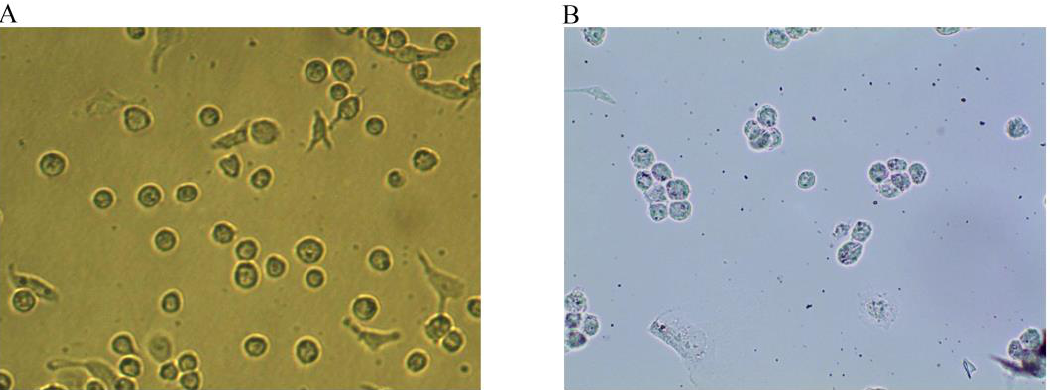
Figure 1. Macrophages and Oil red O staining maps of foam cells (Magnification, ×100). ( A ) After 24 h of PMA stimulation, the cells differentiated into macrophages. ( B ) After 48 h of incubation with 50 ng/mL ox-LDL, the macrophages developed into foam cells, and intracellular lipid droplets were stained with Oil red O.